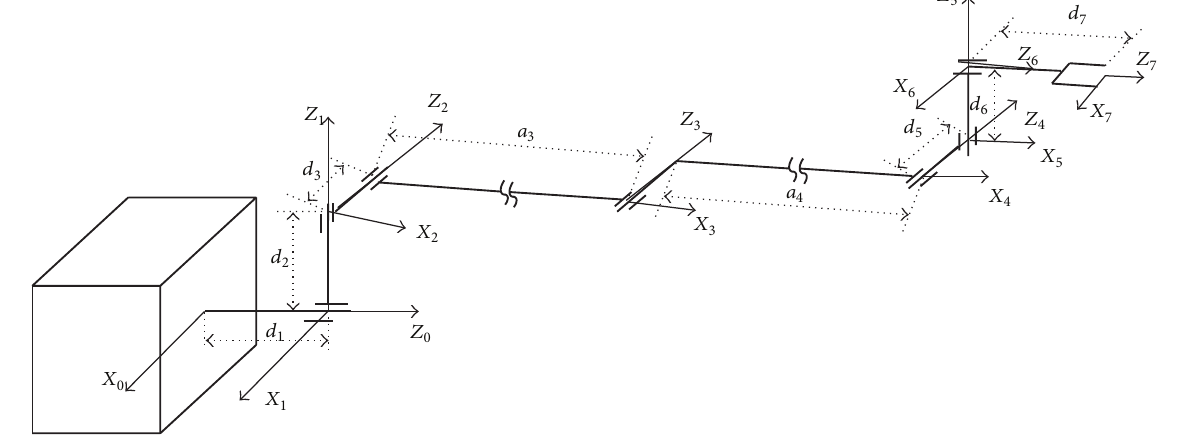
Figure 4: Coordinate systems of 7 DOF space manipulator.